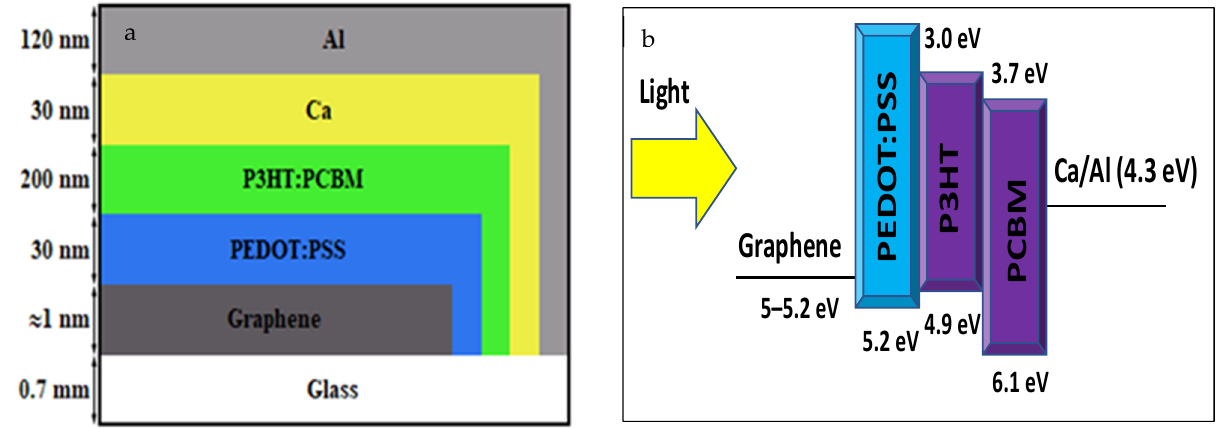
Figure 3. ( a ) The vertical architecture of an OPV device with a CVD graphene film as a transparent electrode (anode) and ( b ) the energy level diagram of graphene electrode in OPV.